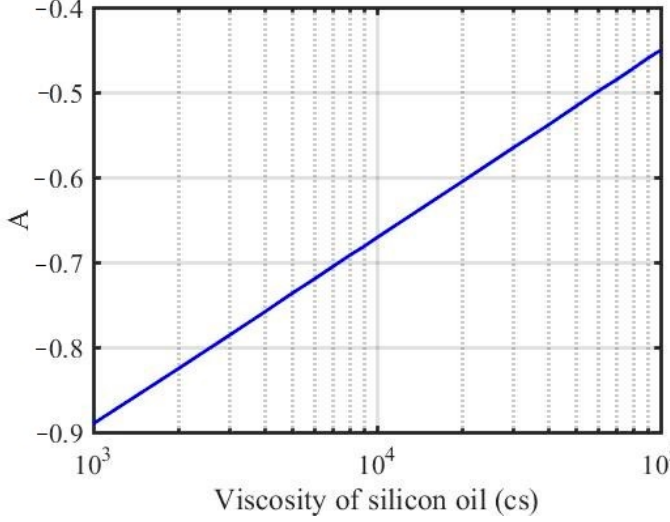
Figure 1. The relationship between constant A and the viscosity of silicon oil.